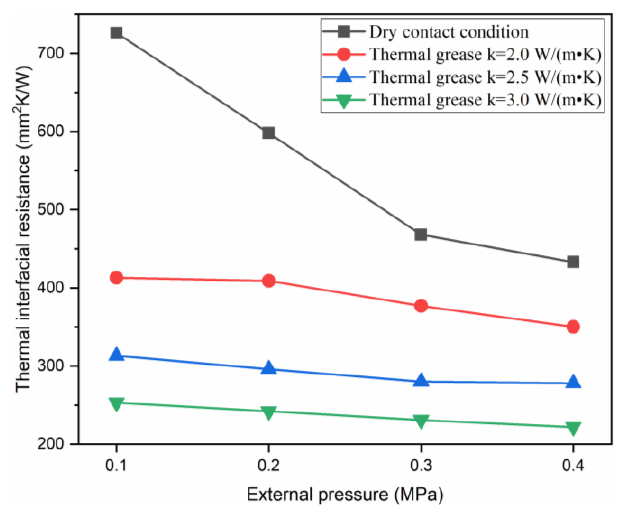
Figure 11. The thermal interfacial resistance at di ff erent external pressures with thermal greases used as thermal interface